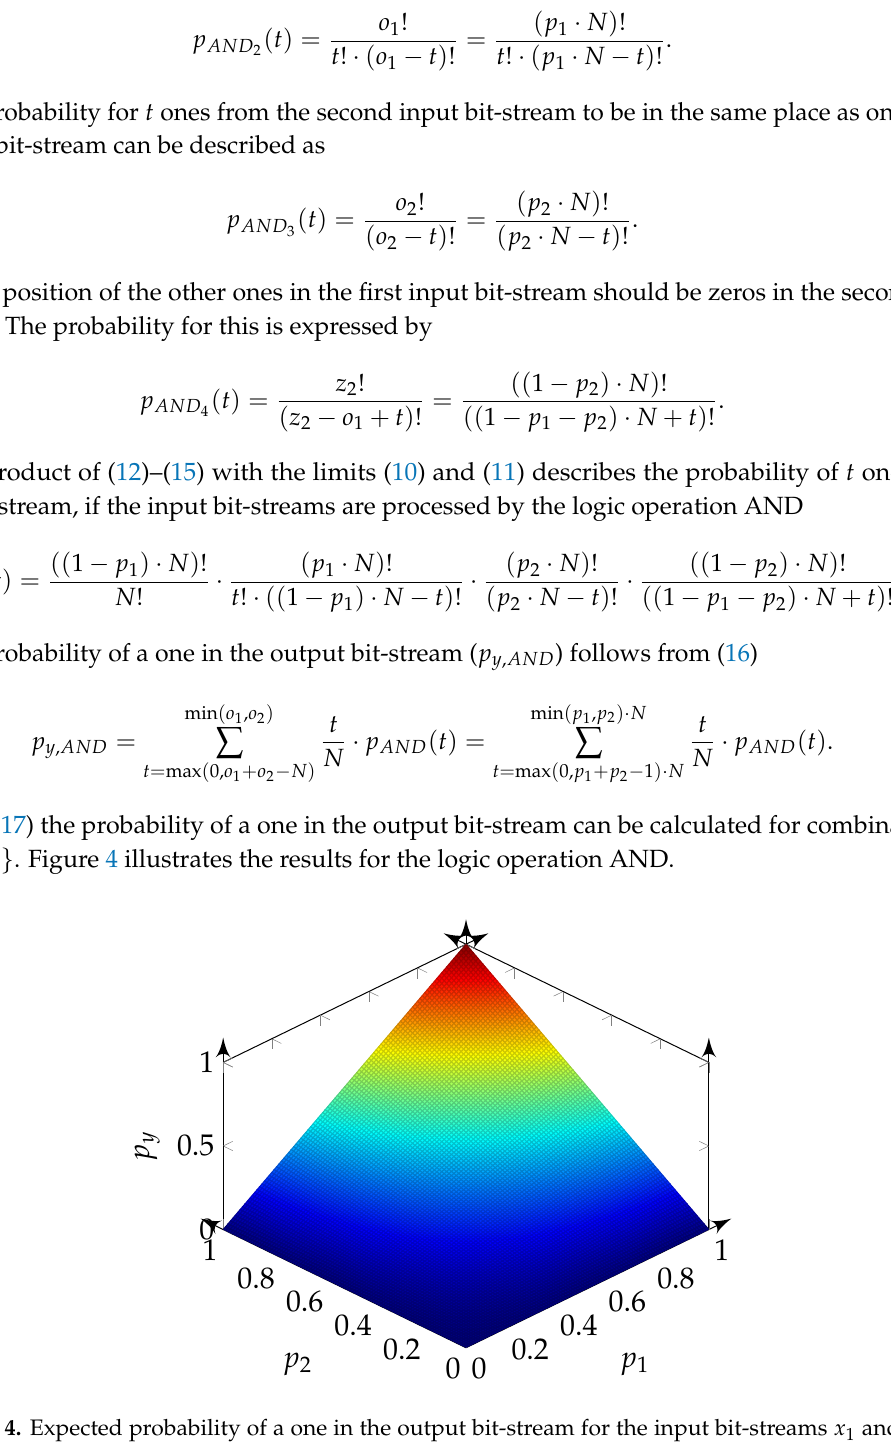
Figure 4. Expected probability of a one in the output bit-stream for the input bit-streams x 1 and x 2 , with the probability of ones p 1 2 , operated by |